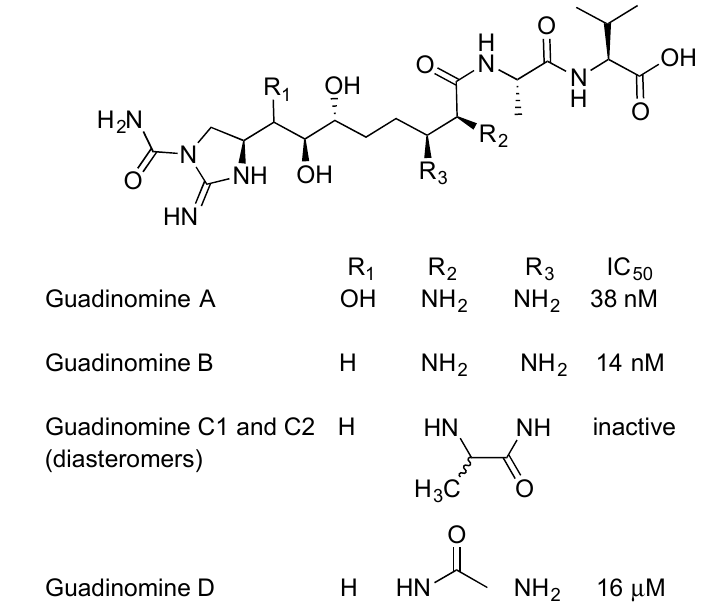
Figure 7. Guadinomines isolated from Streptomyces sp. K01-0509, and their activity against enteropathogenic Escherichia coli